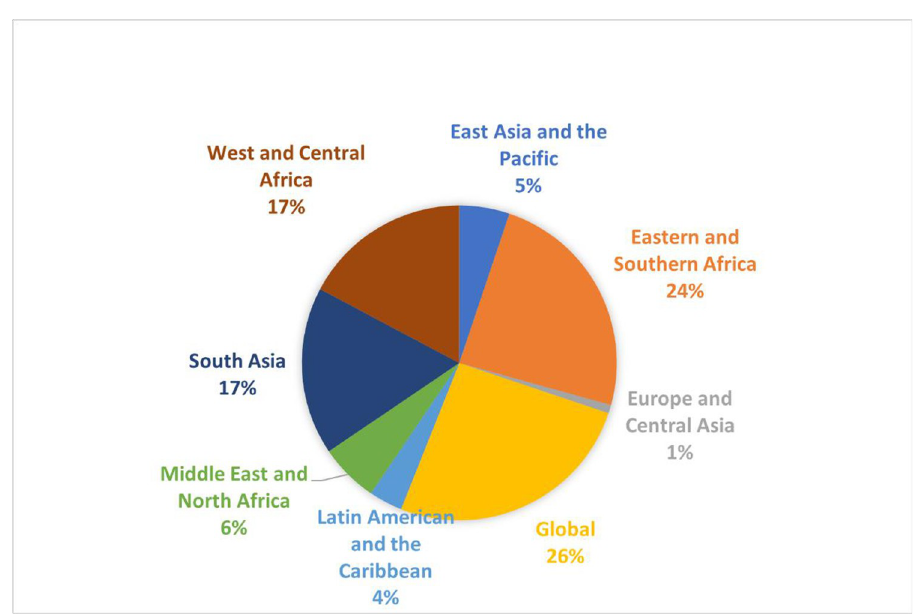
Fig 1. Regional representation of respondents. Regions identified by respondents as the main focus of their work; if respondents work across multiple regions, they could select ‘global’.